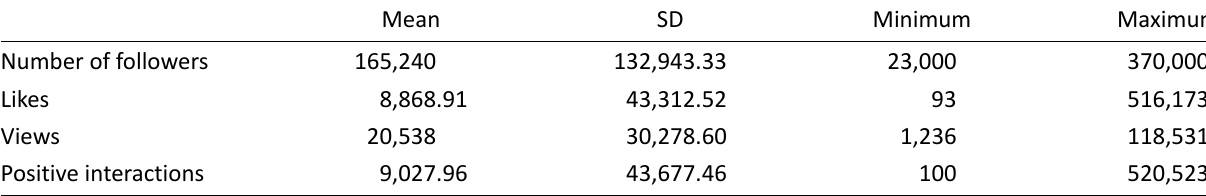
Table 2. Degree of commitment between users and Instagrammers.